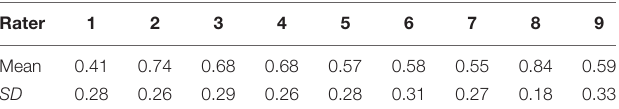
TABLE 5 | Means and standard deviations for raters’ scorings across all indicators in the empirical example.